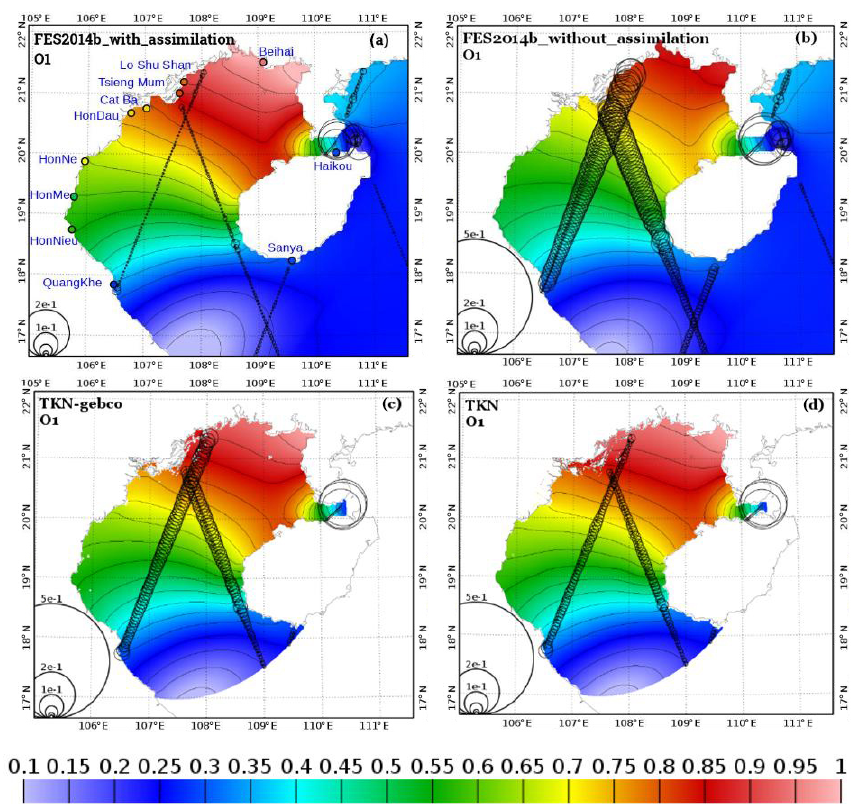
Figure 5. O 1 tidal amplitude (in meters) from different products: (a) FES2014b-with-assimilation, (b) FES2014b-without-assimilation, (c) TKN-gebco, and (d) TKN. The circle diameter is proportional to the complex error (Appendix; Eq. A2) between the solutions and satellite altimetry (in meters). The colored circles denote the amplitude of O 1 harmonic measured at the corresponding tide gauge